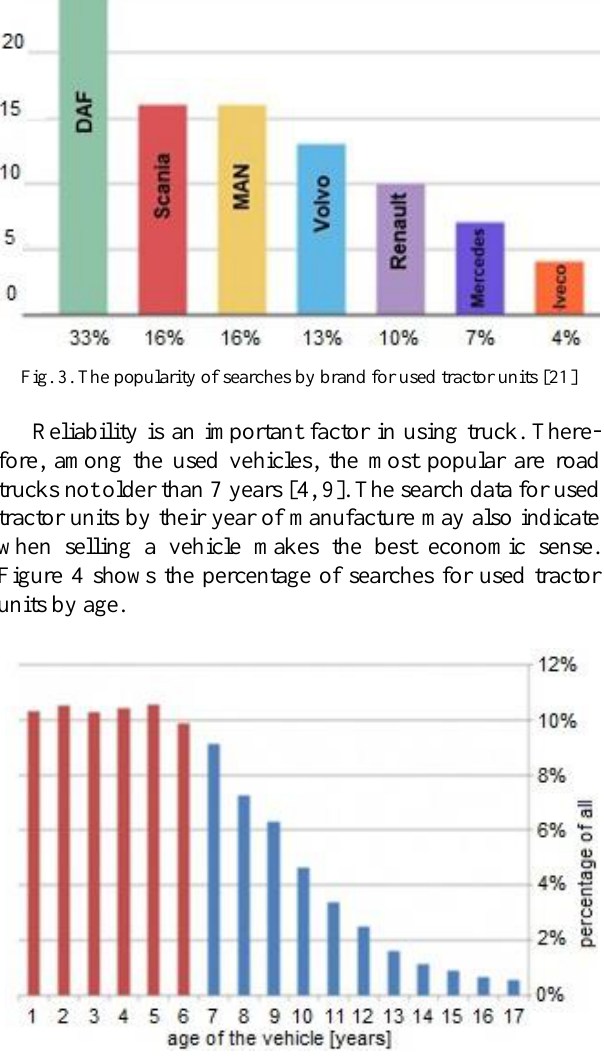
Table 1. Registration of new road tractor units in Poland [6, 17] Brand